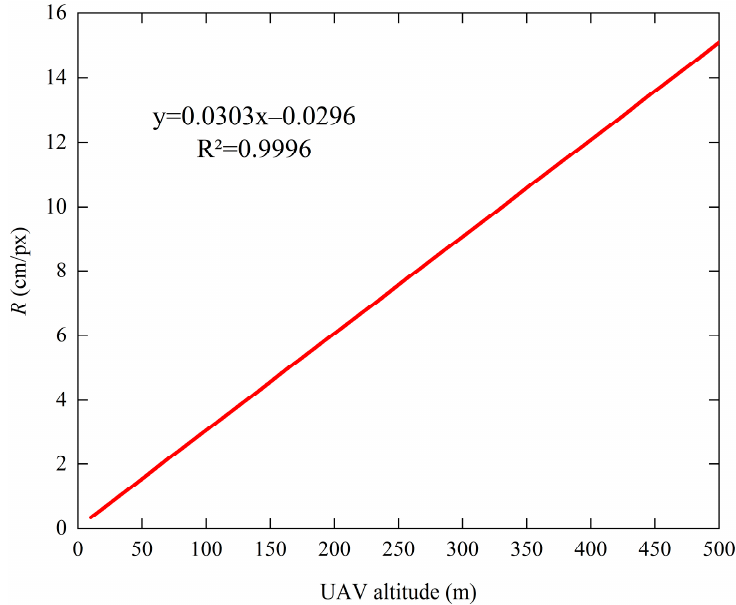
Figure 2. Fitting curve between the unit pixel length and actual length in remote sensing images at the different